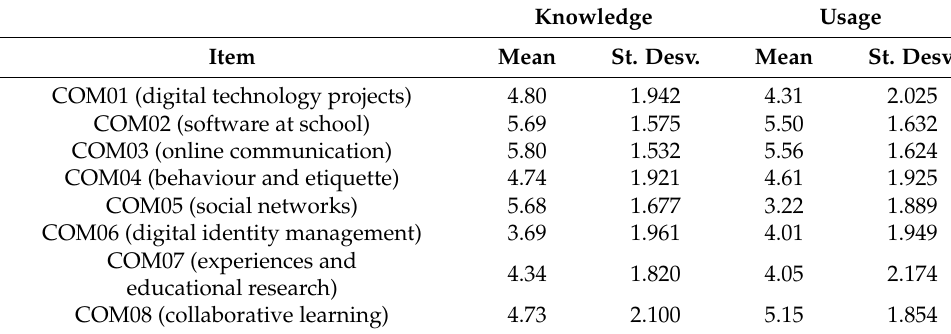
Table 8. Communication tools (COM).